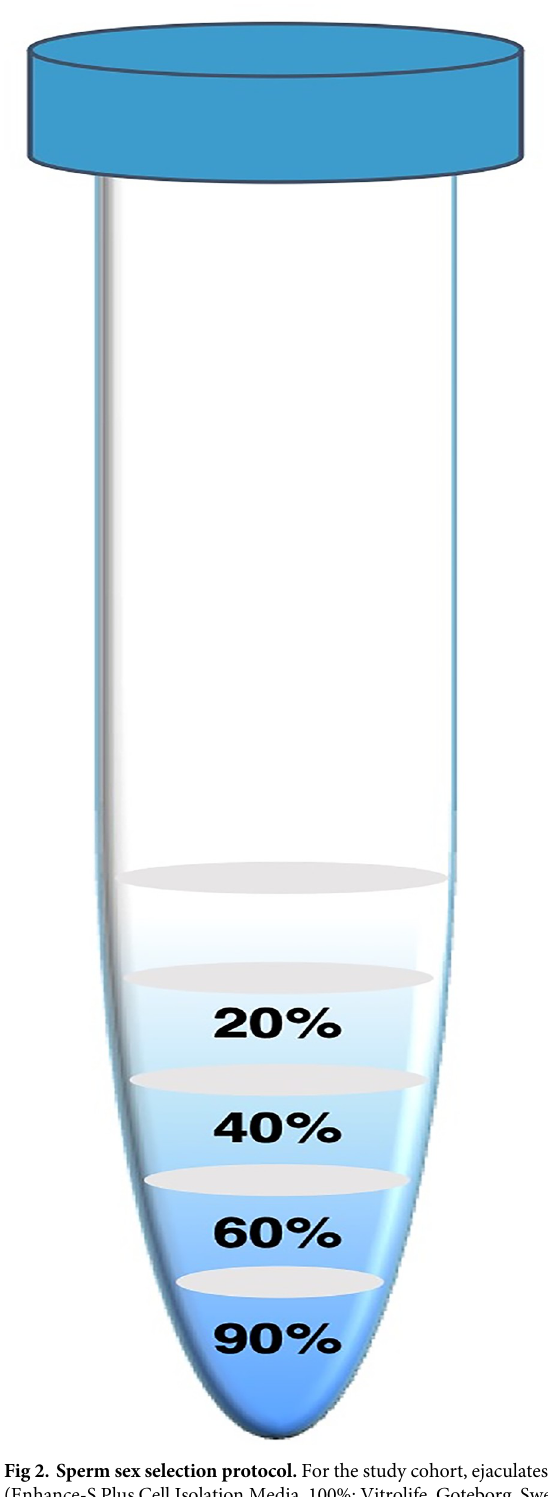
Fig 2. Sperm sex selection protocol. For the study cohort, ejaculates were processed by a multilayer density gradient (Enhance-S Plus Cell Isolation Media, 100%; Vitrolife, Goteborg, Sweden) comprised of four concentrations: 20%, 40%, 60%, and 90%. After removing the seminal fluid, the resuspended sperm pellet was layered on top, and spermatozoa were able to self-select for 90 minutes at 4˚C. Y-bearing spermatozoa were retrieved from the upper, 20% layer, and heavier X-bearing spermatozoa were retrieved from the bottom, 90% layer.